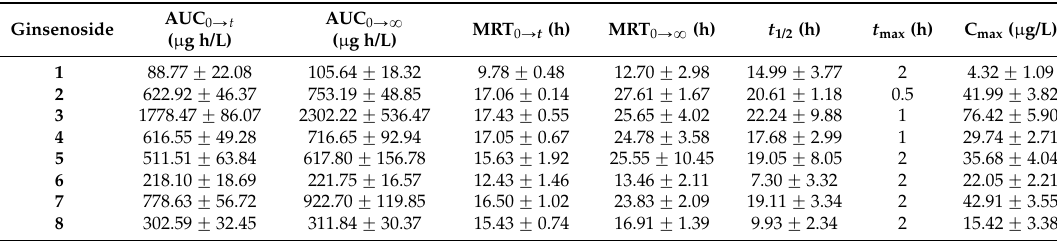
Figure 3. The concentration-time profiles of eight ginsenosides in GTSSL after oral administration at a dose of 400 mg/kg to rats ( n = 6). Table 3. The pharmacokinetic parameters of eight ginsenosides in GTSSL after oral administration at a dose of 400 mg/kg to rats ( n = 6).